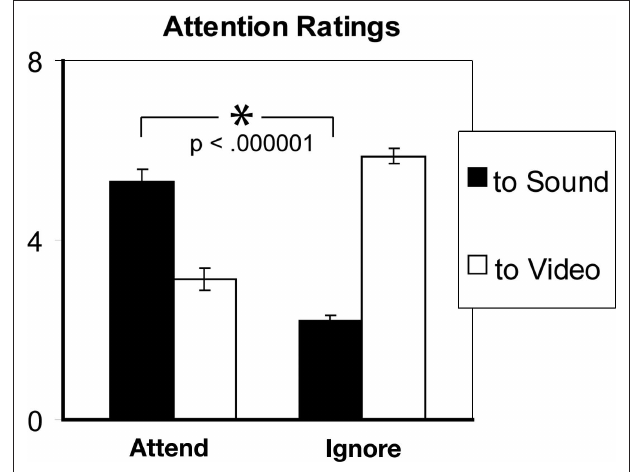
FIGURE 3 | Average attention ratings (1 = “Absent”, 7 = “Complete”) collected from 16 subjects for the two conditions. Error bars indicate standard-error of the mean (SEM). Ratings confi rm the relatively stronger attention to sounds in the attend-sounds task (Attend) compared to the ignore-sounds task (Ignore).